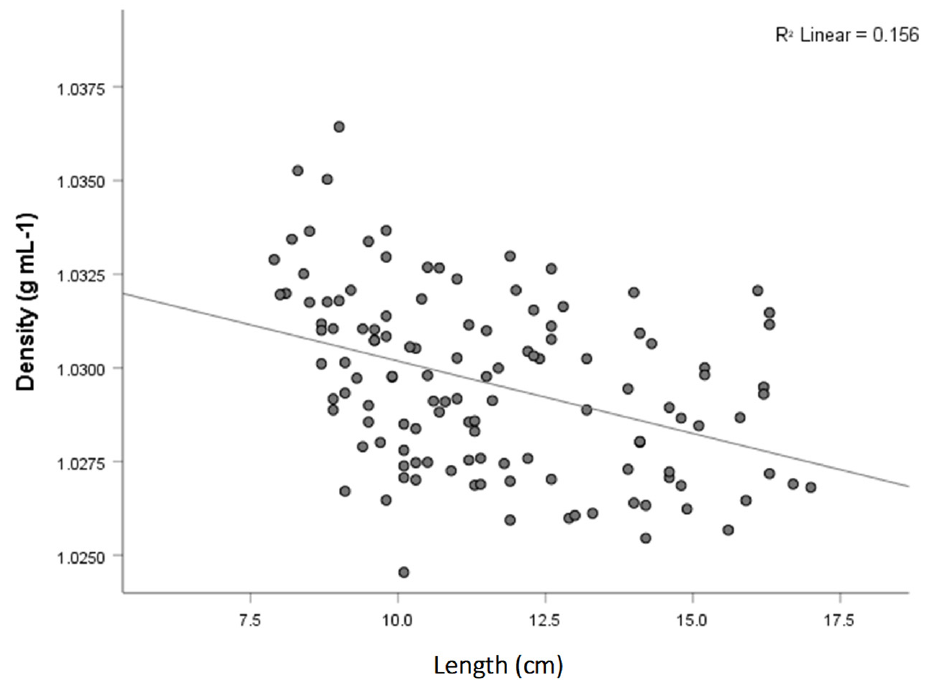
Figure 7. A scatterplot with a fit line between lumpfish body density and length ( n = 123). Location D was excluded from the analysis.